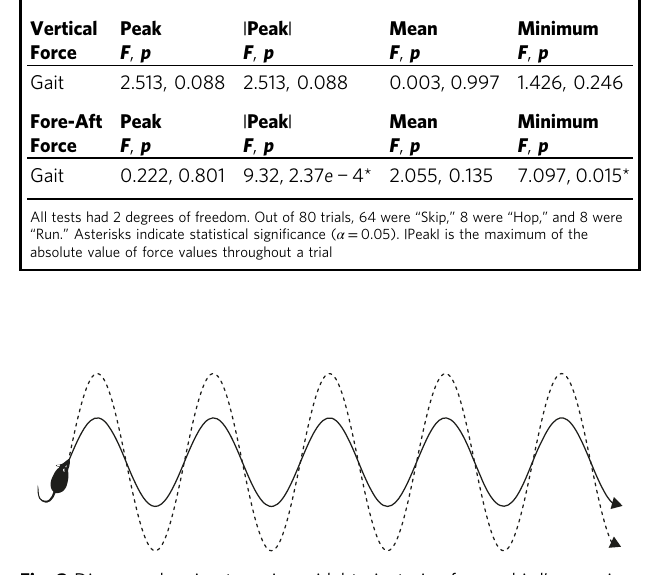
Fig. 3 Diagram showing two sinusoidal trajectories from a bird ’ s eye view, traveling from left to right . The dashed path has twice the amplitude of the solid path. Consequently, the solid path has twice the variance of the dashed path, though both paths have the same unpredictability ( H